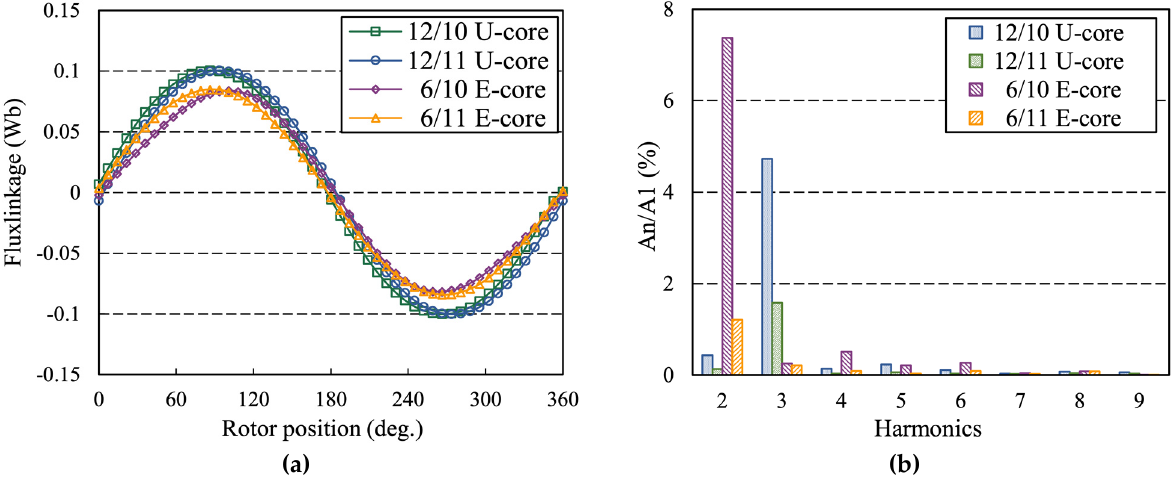
Figure 5. No-load air-gap PM flux linkage and harmonic distribution of the four candidates. ( a ) PM flux linkage waveforms; ( b ) harmonic distributions.